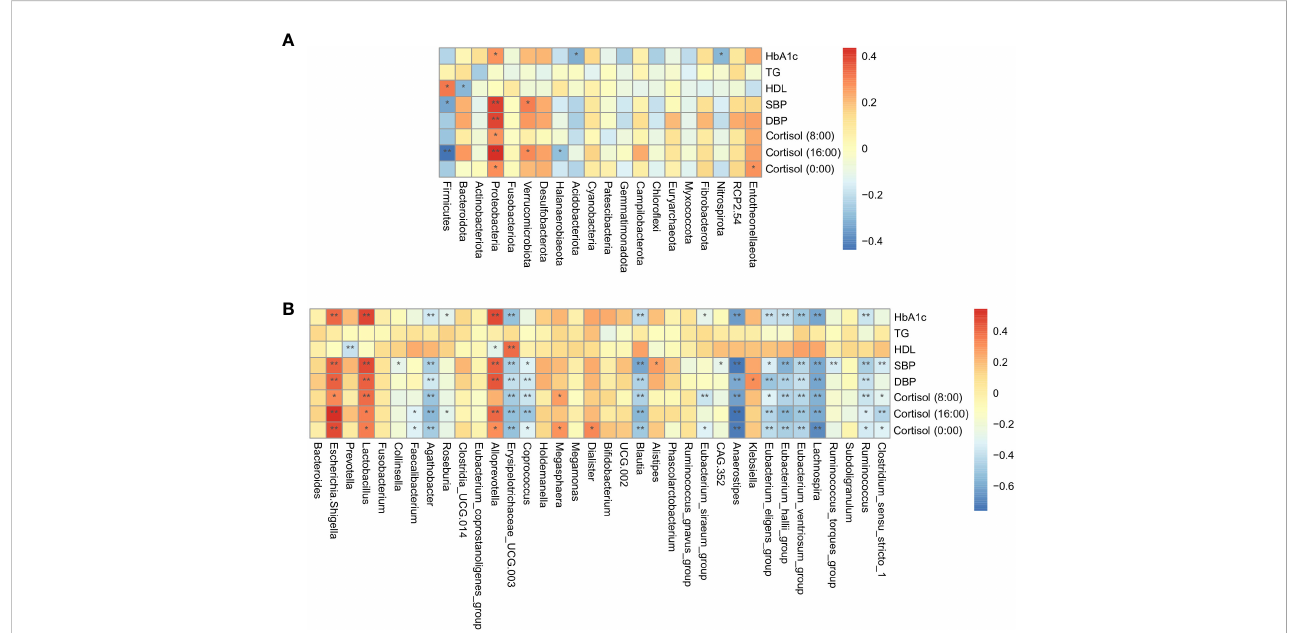
FIGURE 3 Correlation analysis of gut microbiota and clinical indicators. (A) : The correlation of speci fi c taxa at the phylum level and clinical indicators between CS patients and healthy controls. (B) : The correlation of speci fi c taxa at the genus level and clinical indicators between CS patients and healthy controls. TG, triglyceride; HDL-C, high-density lipoprotein cholesterol; HbA1c, glycosylated hemoglobin; SBP, systolic blood pressure; DBP, diastolic blood pressure * P < 0.05; ** P